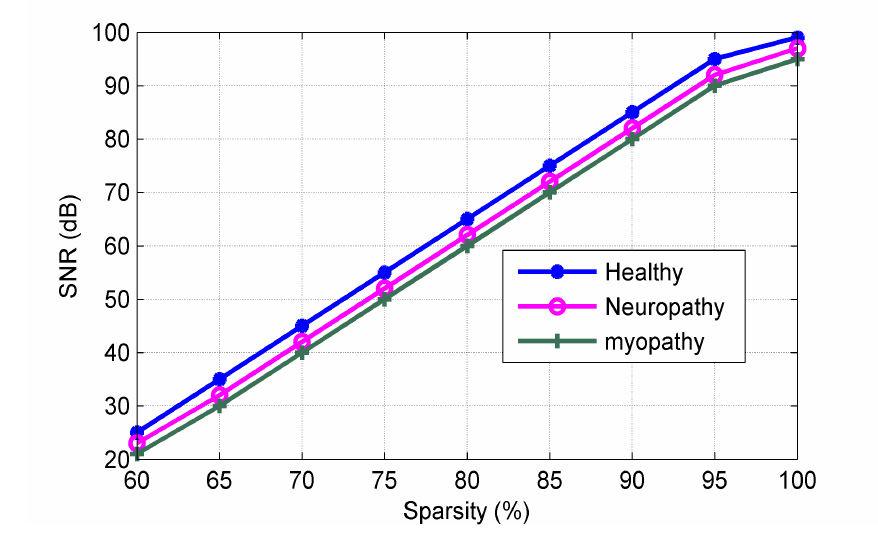
Figure 8. SNR for three types of sEMG signals.